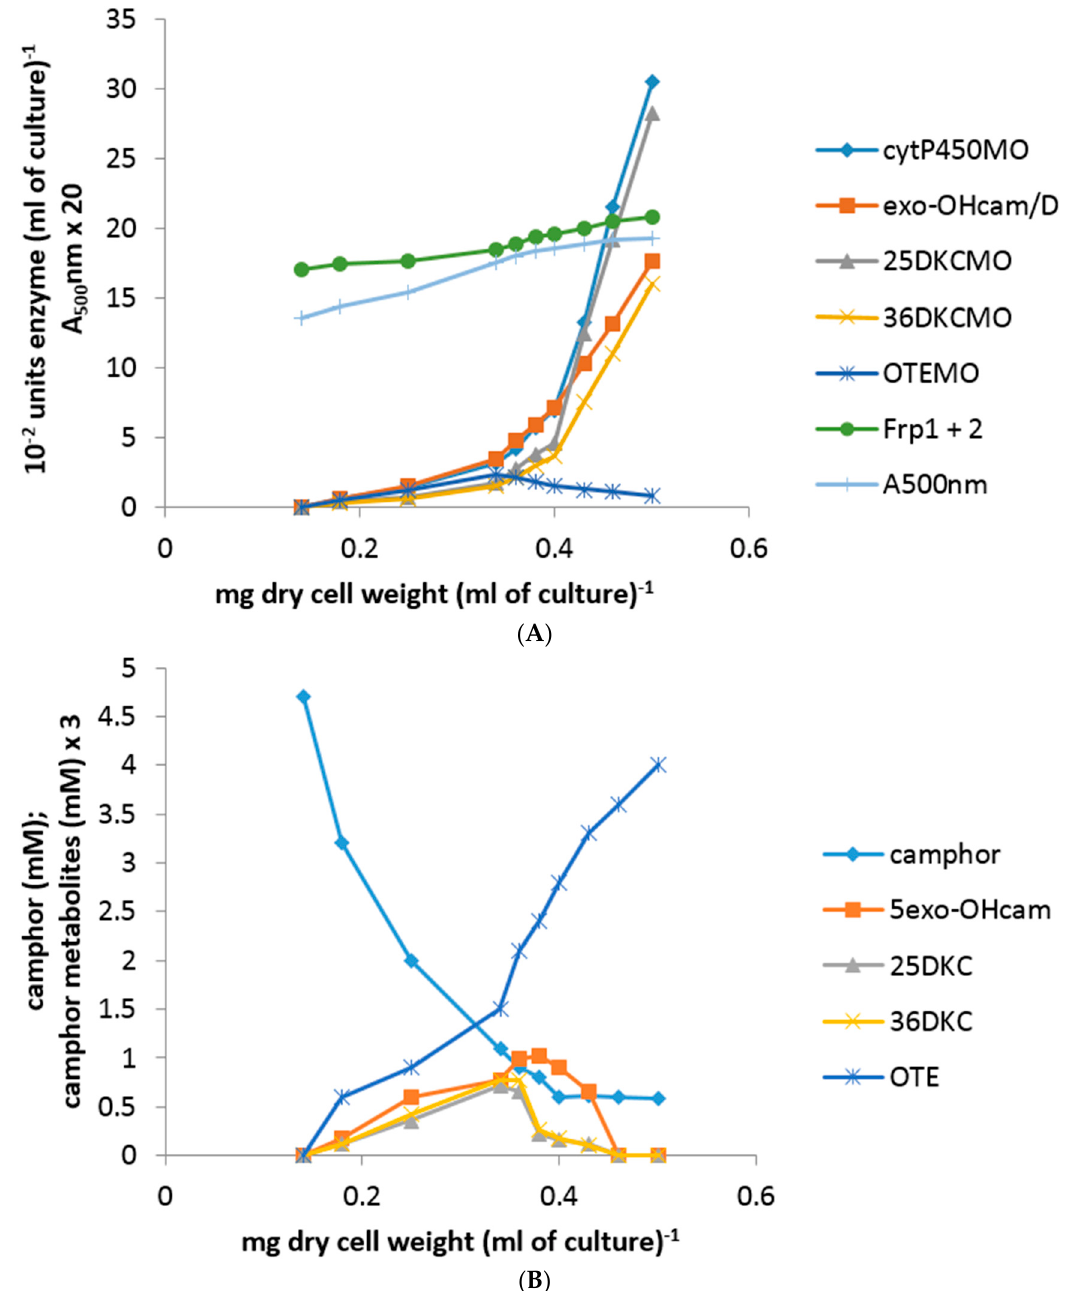
Figure 4. ( A , B ) Changes in the optical density (A 500 nm) of P. putida NCIMB 10007 following the sequential addition of ( rac )-camphor and isobutyryl-CoA (+60 min) to succinate minimal medium and concomitant changes in the activity of key enzymes and metabolic intermediates of the camphor degradation pathway.